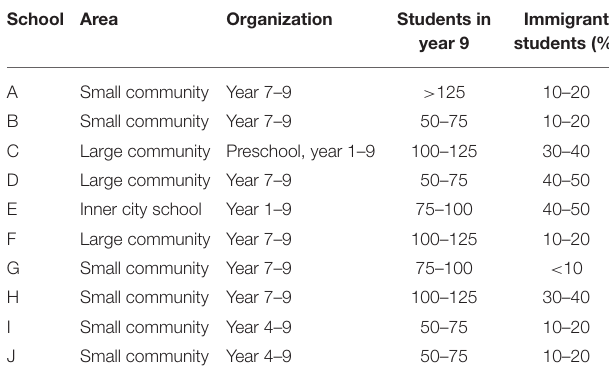
TABLE 1 | Data for the schools in the sample.